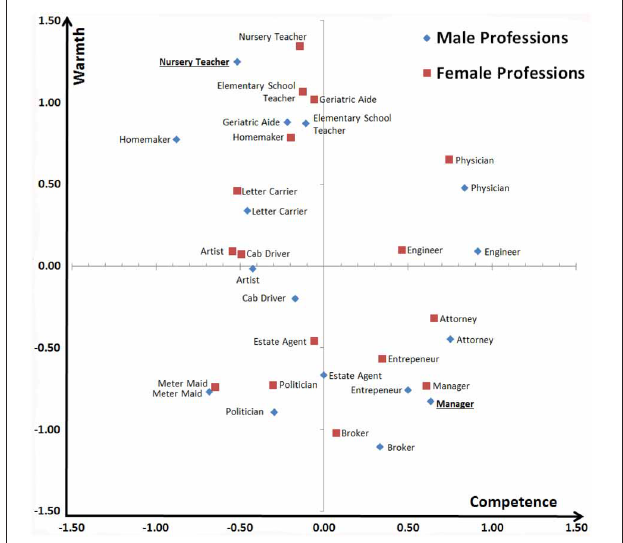
FIGURE 1 | Pretest ratings of warmth and competence ( z -standardized means) for 32 professional groups.